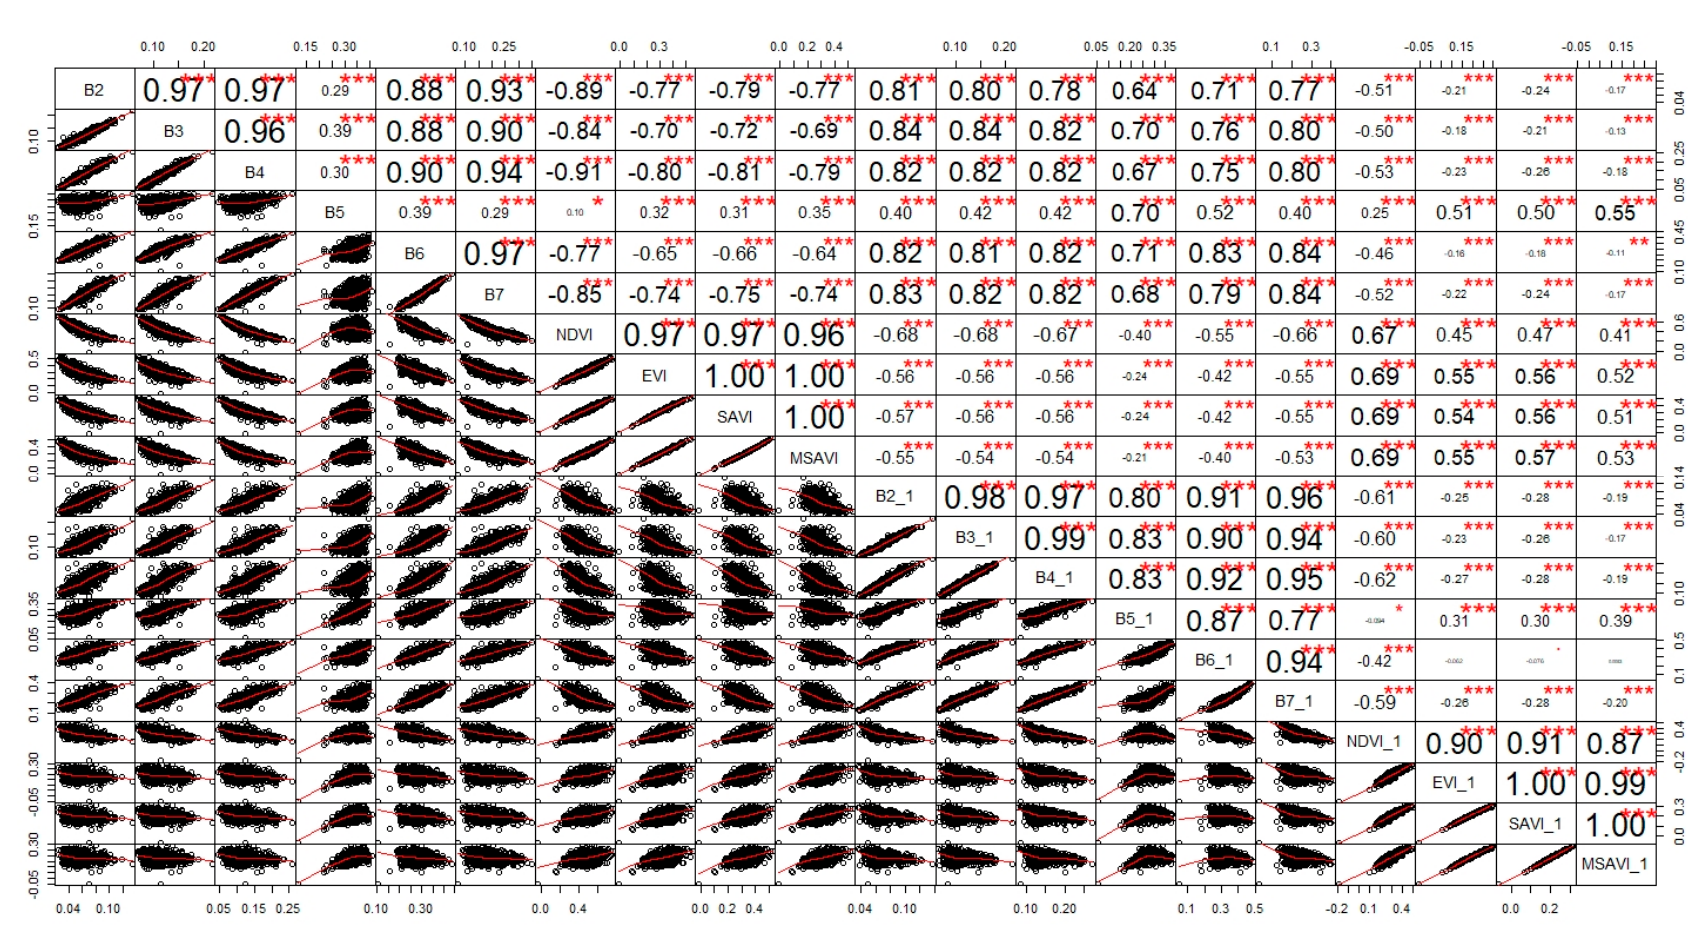
Figure A4. Correlated variables.